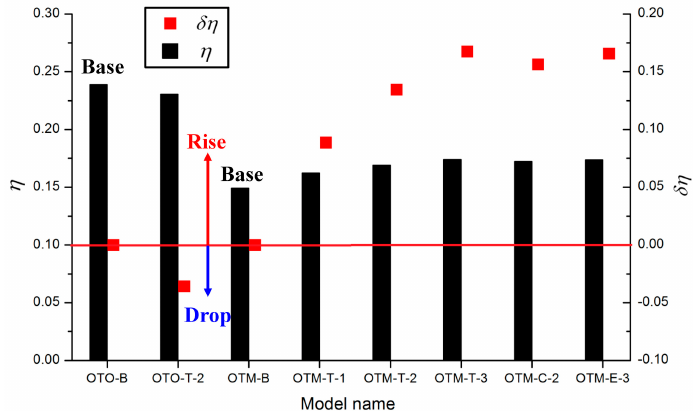
Figure 19. Summary of influence on isentropic efficiency for different turbine models.